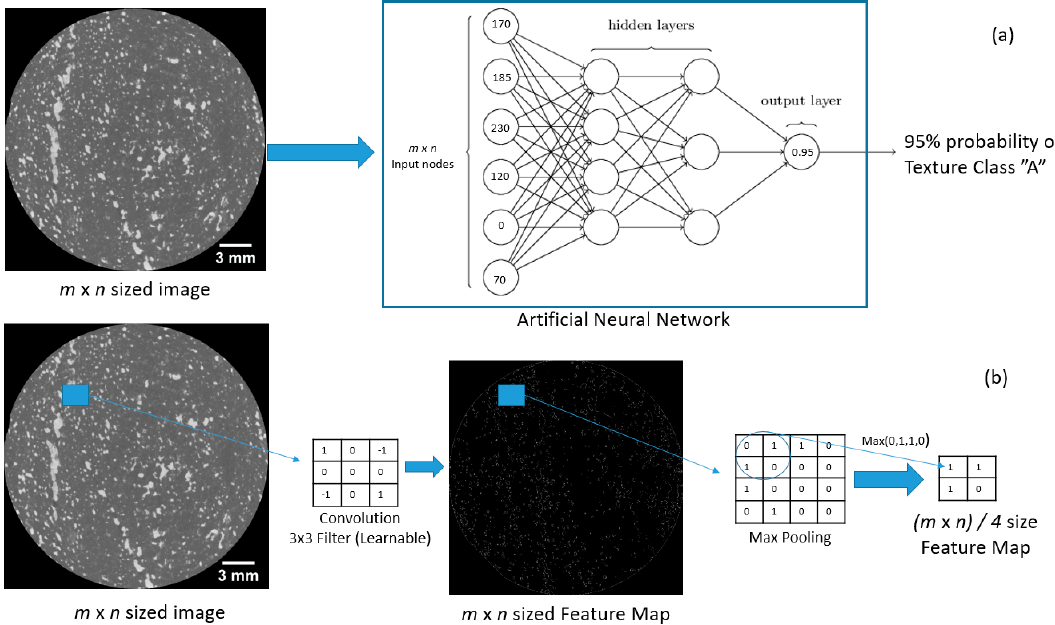
Figure 9. ( a ) ANN applied on a µ CT drill core slice images; ( b ) CNN applied on a µ CT drill core slice images. In an ANN each pixel in the image is inputted directly, creating an m × n amount of input nodes, which is very large for typical µ CT slice images. In a CNN the image is convoluted first with filters to produce feature maps. These filters can be more than one and are learnable during the training phase. The feature map is then pooled, for example by taking maximum values in a 2 × 2 neighborhood, so it is downsized by the factor of four. This scheme represents the neural network application in image recognition (recognizing the texture class of a drill core slice) while, for phase segmentation, the input can be changed to the mask image of each phase.